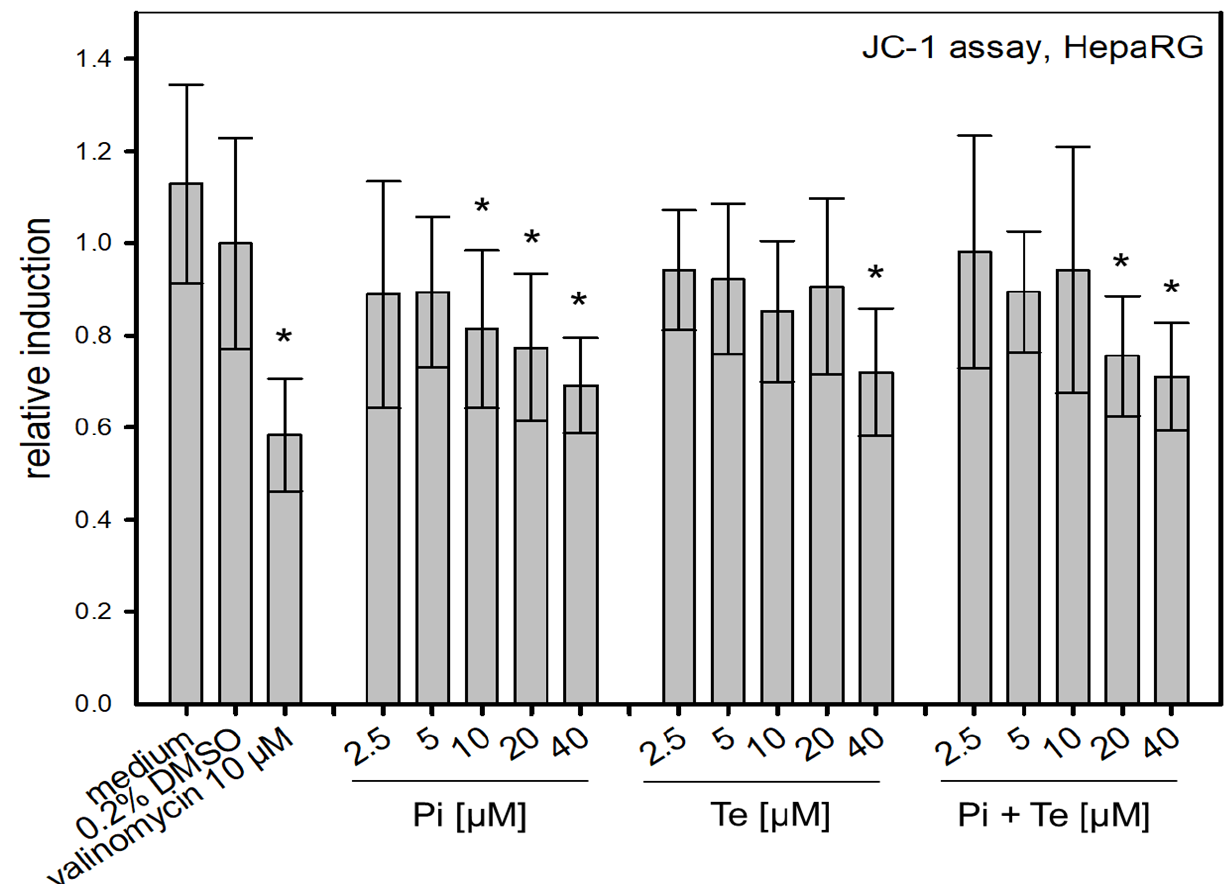
Figure 5. Alteration of the mitochondrial membrane function measured via the JC-1-assay. Mitochondrial disruption is caused by propiconazole (Pi), tebuconazole (Te), and their combination in HepaRG cells after 6 h of treatment from 2.5 µ M to 40 µ M. The relative induction was calculated based on the solvent control (normalized for the value measured for 0.2% DMSO). Statistical significance was reached at p < 0.05 and is indicated by asterisks (Mann–Whitney rank sum test against the solvent control). Valinomycin (10 µ M) was applied for 24 h and served as positive control.